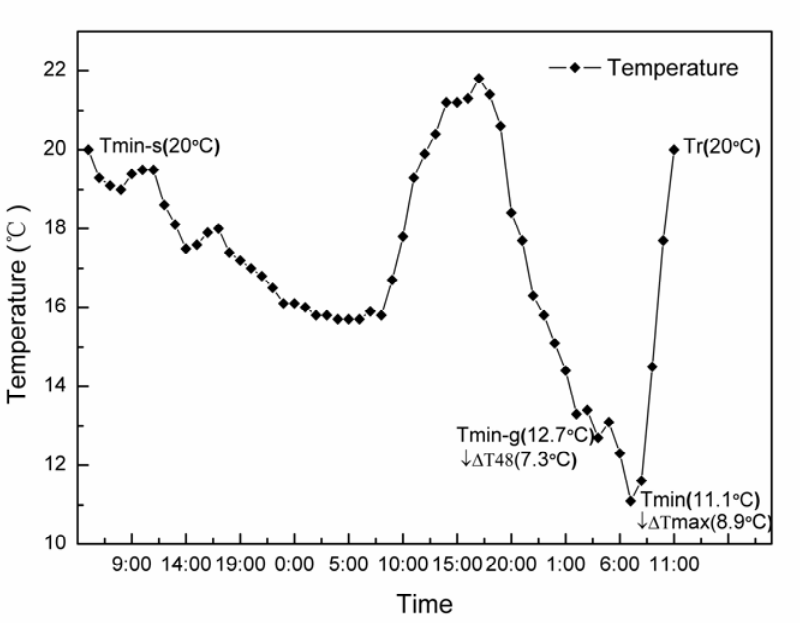
Figure 1. Temperature changes over time during the cold air process. Tmin-s: the starting minimum temperature of the cold air; Tmin-g: the minimum temperature for cold air grading; Tmin: the minimum temperature; Tr: the rewarming temperature ; ↓∆ T48 = Tmin-s − Tmin-g ； ↓∆ Tmax = Tmin-s −